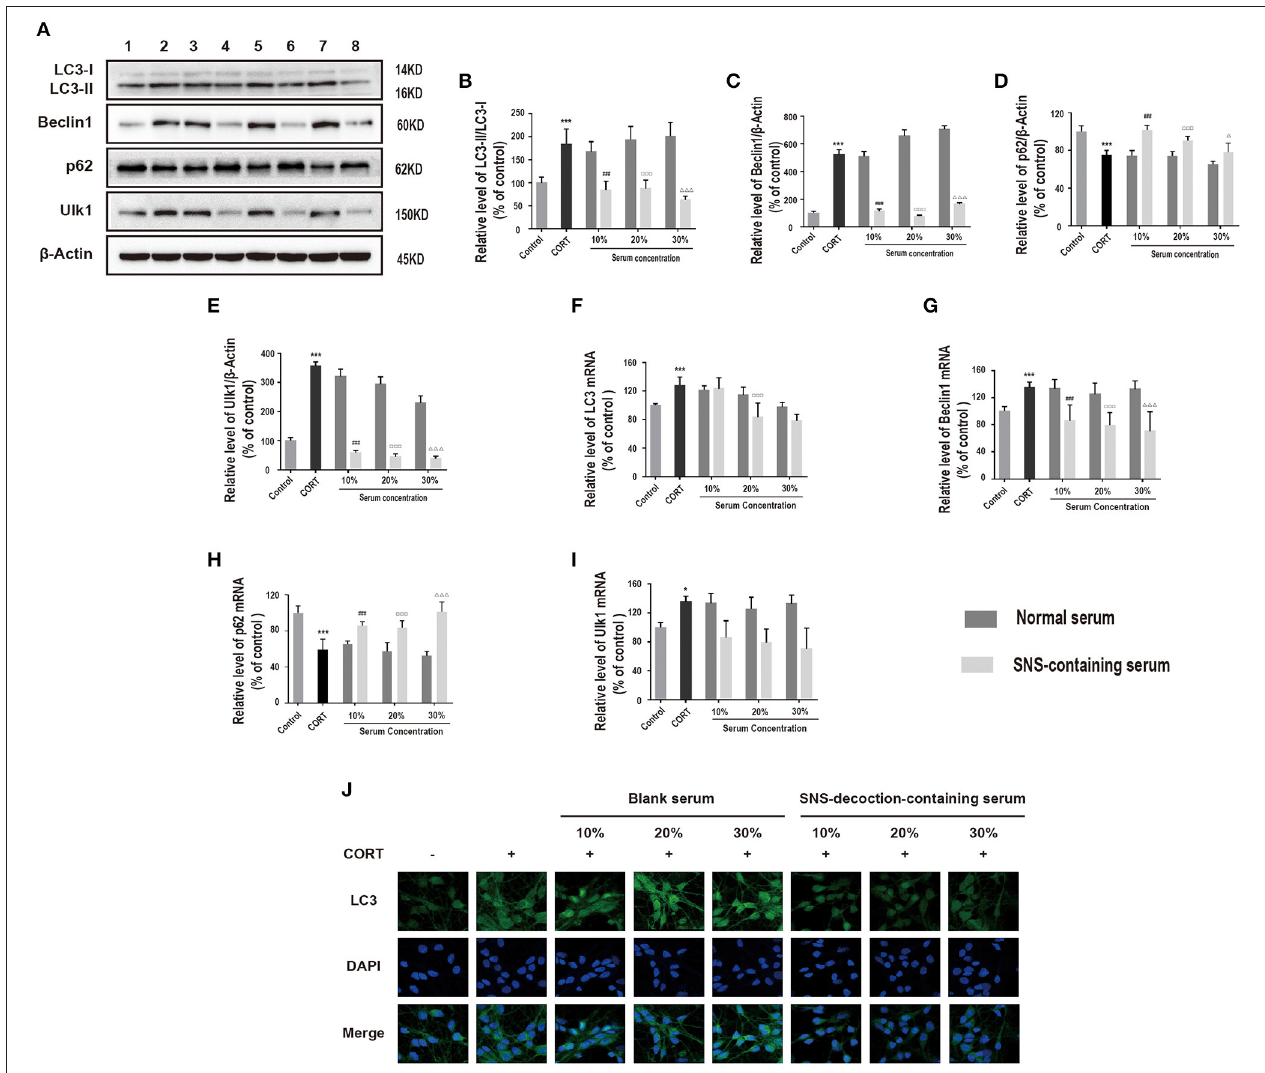
FIGURE 3 | Cells were incubated with 200 µ M corticosterone and SNS-containing serum for 24h. (A–E) Western blot and quantitative analyses of LC3-II/LC3-I protein ratio, and Beclin1, p62 and ULK1 protein expression levels. ( n = 3). (F–I) qRT-PCR analysis of LC3, Beclin1, p62 and ULK1 expression. ( n = 3). (J) Immunofluorescence analysis of LC3 expression. * P < 0.05, *** P < 0.01 vs. control group; ### P < 0.01 vs. 10% normal serum group; △ P < 0.05, △△△ P < 0.01 vs. 20% normal serum group; 111 P < 0.01 vs. 30% normal serum group, ( n = 3). 1:control group; 2: corticosterone group; 3: 10% normal serum + corticosterone group; 4: 10% SNS-containing serum + corticosterone group; 5: 20% normal serum + corticosterone group; 6: 20% SNS-containing serum + corticosterone group; 7: 30% normal serum + corticosterone group; 8:30% SNS-containing serum + corticosterone group.